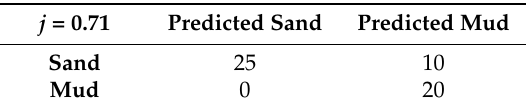
Figure 11. Orthomosaics for the three Neath flights ( a – c ), sand points marked as red squares and mud points as red circles; and, the corresponding classifications ( d – f ). Sand areas are marked blue and mud areas yellow.